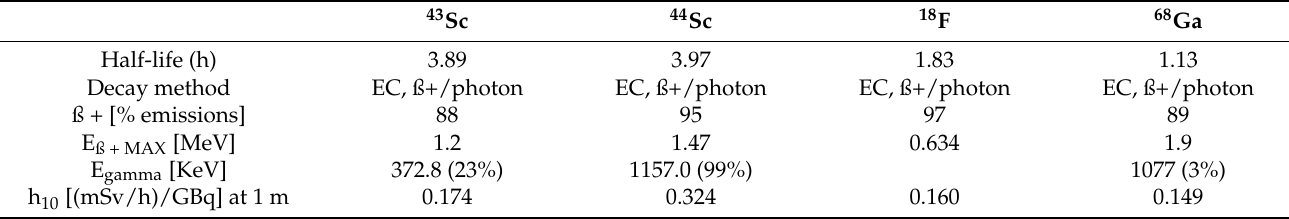
Table 2. Physical decay characteristics of the radionuclides investigated.